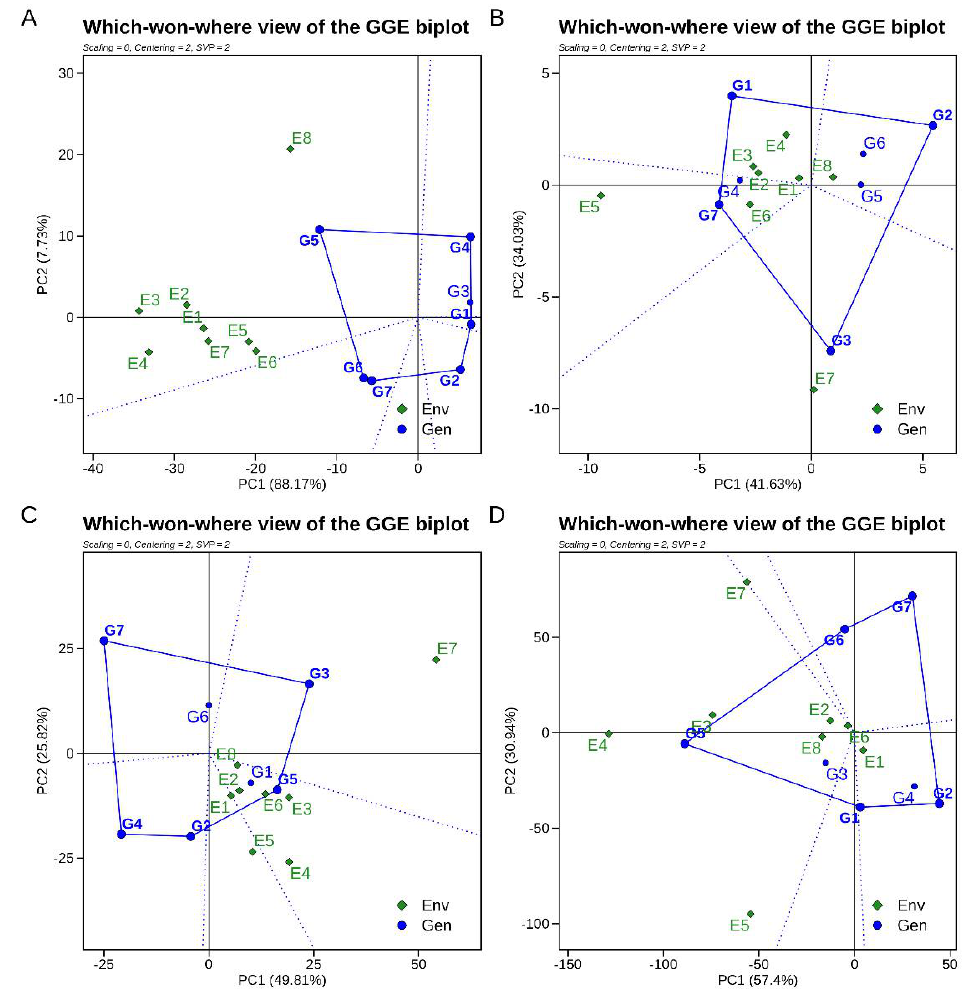
Figure 2. The GGE biplot polygon of the ‘Which − won − where’ pattern to identify the best cultivar in each location of 5 GSR lines and 2 control lines grown under eight environments in the year 2020 for ( A ) plant height, ( B ) the number of tillers, ( C ) grain yield, and ( D ) straw yield. The biplots were created with centering = 0, SVP = 2, and scaling = 0 parameters.